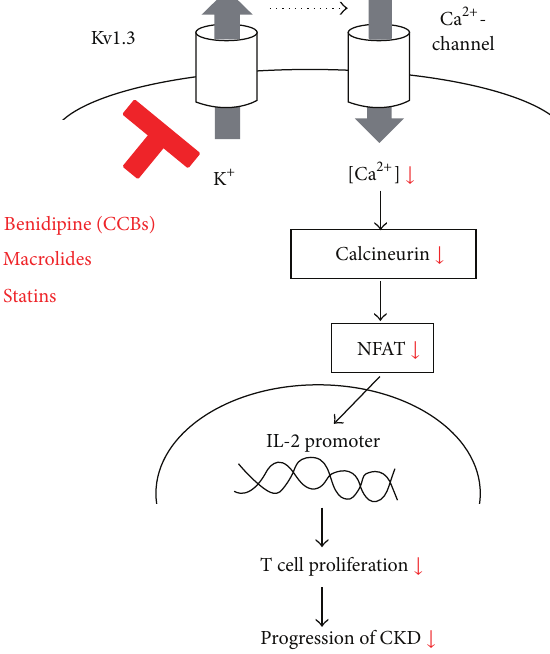
Figure 6: Therapeutic implications of targeting lymphocyte Kv1.3- channels in the treatment of CKD. In addition to benidipine, one of the calcium channel blockers (CCBs), macrolide antibiotics, and statins, which effectively inhibit lymphocyte Kv1.3-channels, could also potentially be useful in the treatment or the prevention of chronic kidney disease